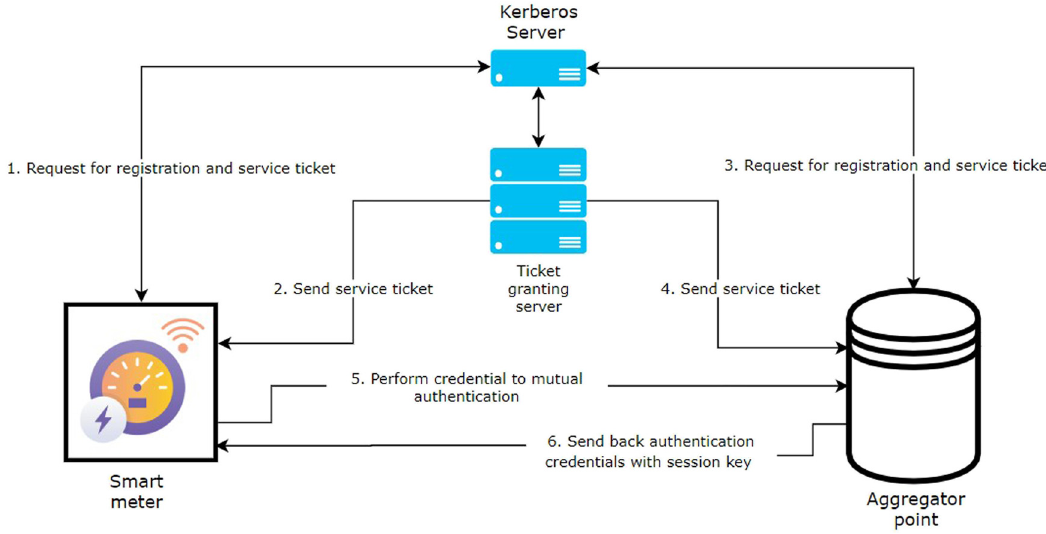
Figure 1: Architecture of proposed